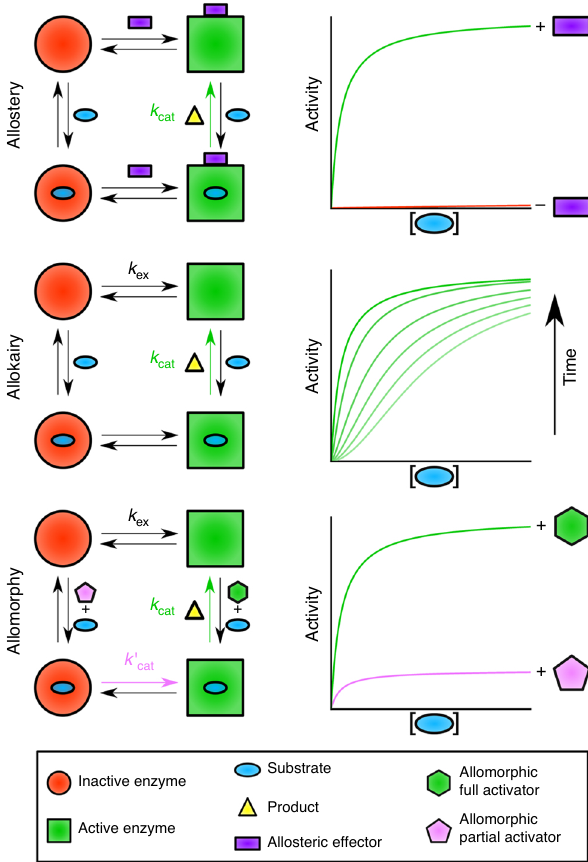
Fig. 7 Mechanisms of regulation and activity pro fi les in monomeric enzymes. In allostery, binding (or reaction) of an allosteric effector (purple rectangle) outside of the active site shifts the enzyme population from an inactive form (red circle and red pro fi le) to an active form (green square and green pro fi le), which stimulates the transformation of substrate (blue oval) to product (yellow triangle) at the catalytic rate ( k cat , green arrow). In allokairy, binding of substrate in the active site shifts the enzyme population from an inactive form to an active form, at an exchange rate ( k ex ) that is similar to k cat , resulting in time-dependent activity pro fi les (gradient of light green to dark green pro fi les). Following exhaustion of substrate, the enzyme population returns to the original equilibrium position. In allomorphy, reaction of the activating substrate, termed here allomorphic full activator (green hexagon), in the active site shifts the enzyme population from an inactive form to an active form, which stimulates the transformation of the native substrate (blue oval) to product (yellow triangle) at the maximal catalytic rate ( k cat , green arrow and green pro fi le). However, reaction of alternatives substrates, termed here allomorphic partial activators (pink pentagon), in the active site are unable to shift the enzyme population from an inactive form to an active form, resulting in a slower overall catalytic rate ( k ’ cat , pink arrow and pink pro fi le). The exchange rate ( k ex ) between the two enzyme forms is much slower than k cat . Following exhaustion of the allomorphic activator, the enzyme population returns to the original equilibrium